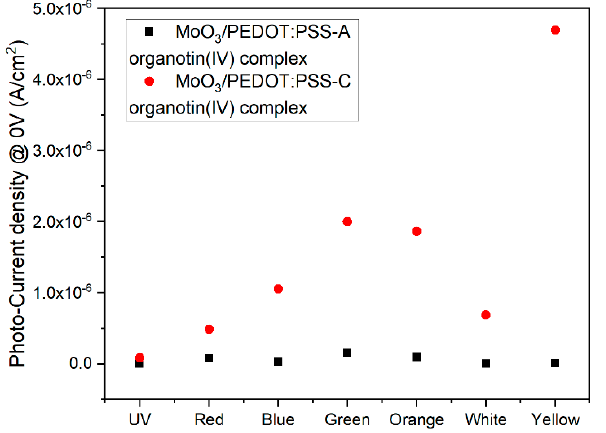
Figure 7. Photocurrent density at 0 V for ITO/MoO 3 /PEDOT:PSS-organotin (IV) complex/Ag devices under different lighting conditions.